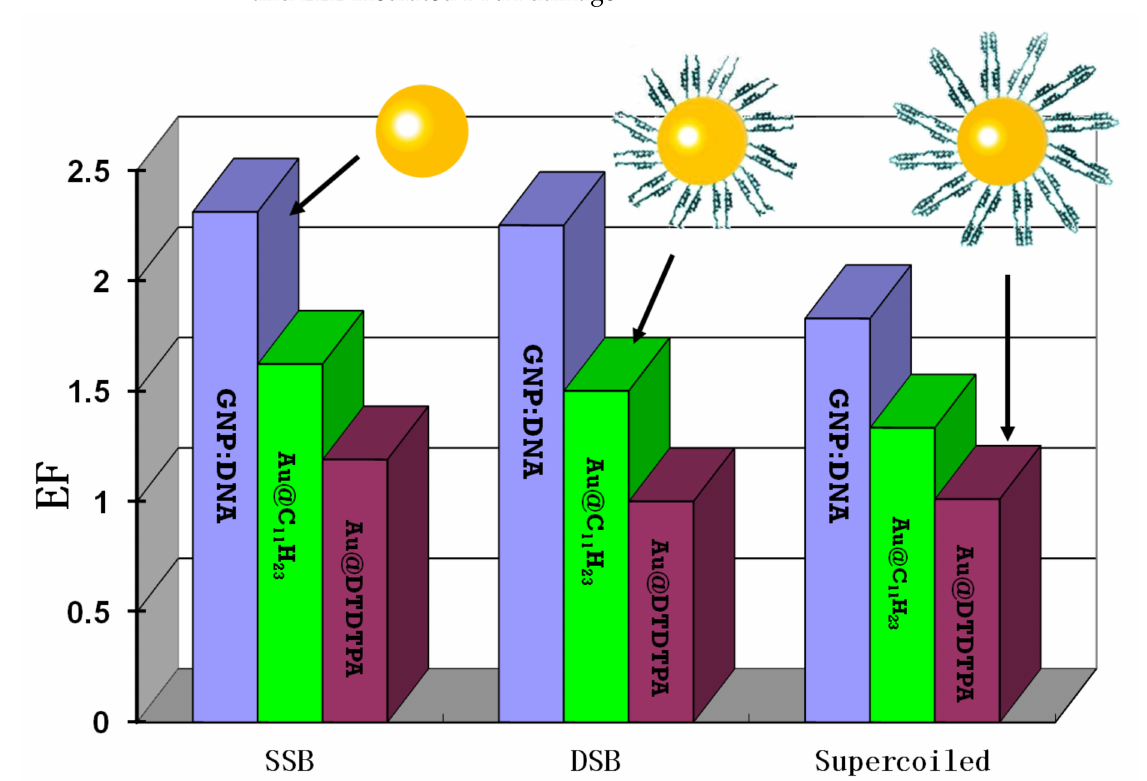
Figure 2. Enhancement factors (EFs) for the formation of single-strand breaks (SSBs), double-strand breaks (DSBs) and loss of supercoiled (LS) induced by 60 keV electrons in GNP–DNA complexes with ratio 1:1 [34]. Each group of three histograms of different colors represent, respectively, SSBs, DSBs and LS. In each group, the EFs were generated by bare GNPs of 5 nm diameter bound to DNA or coated with C 11 H 23 , or DTDTPA (i.e., dithiolated diethylenetriaminepentaacetic) ligands. The corresponding ligand lengths were 2.5 and 4 nm,